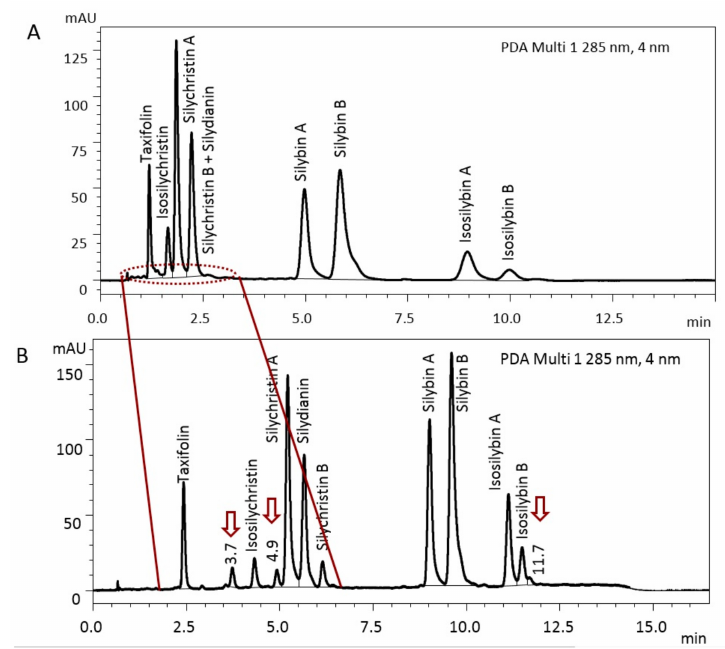
Figure 2. Comparison of the isocratic ( A ) and gradient ( B ) HPLC analytical method for silymarin SM 3. Chromolith RP-18e (100 × 3 mm) column; isocratic conditions: Mobile phase: 2% acetonitrile, 37% methanol, 0.1% formic acid, flow rate 1.1 mL / min, t = 25 ◦ C; gradient conditions: Mobile phase: A = 5% acetonitrile, 0.1% formic acid; B = 80% methanol, 0.1% formic acid; gradient: 0 min 30% B, 12 min 60% B, 13 min 60% B, 14 min 30% B, 16.5 min stop, flow rate 1.1 mL / min, t = 25 ◦ C. The arrows indicate compounds, which have not yet been identified.